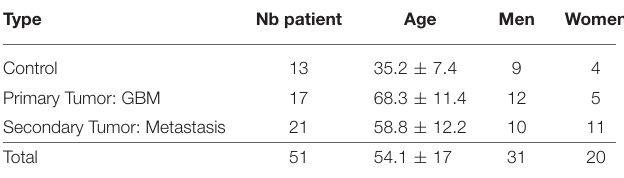
TABLE 1 | Description of